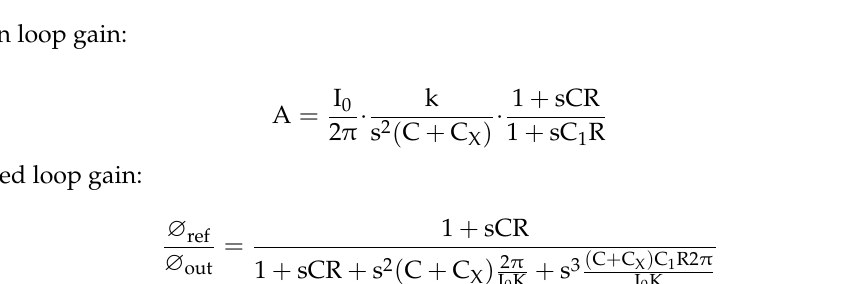
Figure 10. s-Domain analysis block